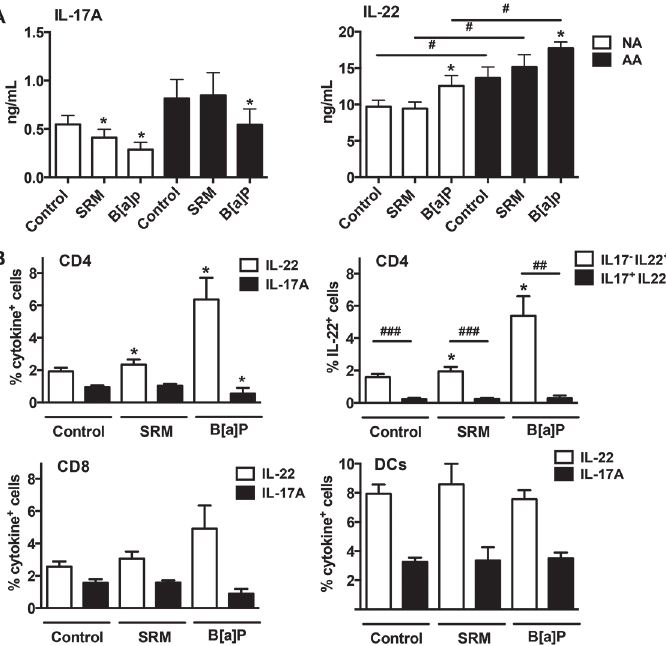
Fig 3. Cytokine profile and cell expression of PAH-stimulated peripheral blood mononuclear cells cultured in Th17 conditions. A IL-17A and IL-22 production by activated peripheral blood mononuclear cells from 6 nonallergic (NA) subjects and 6 allergic asthmatic (AA) patients stimulated or not with SRM or B [a]P for 6 days was determined by ELISA. Results are expressed as mean ± SEM. * P < .05 versus corresponding control. # P < .05 AA versus NA subjects. B Activated peripheral blood mononuclear cells were stimulated or not with SRM and B[a]P, stained with antibodies against cytokine and cell surface markers, and evaluated by flow cytometry. Results are expressed as mean ± SEM percentage of cytokine positive cell populations for n = 7 – 11 subjects. * P < .05 versus corresponding control, ## P < .01, ### P < .001.